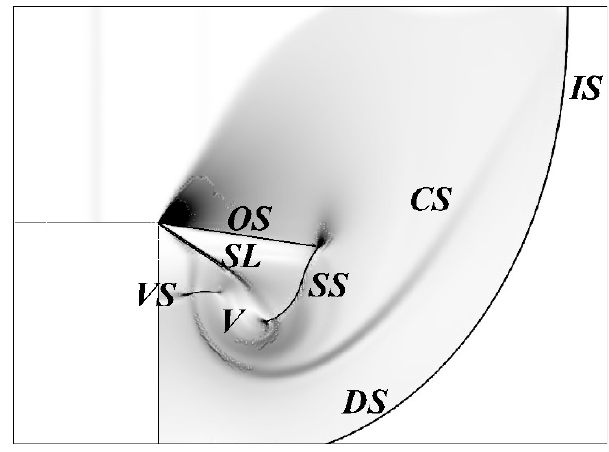
Fig. 3. Schlieren showing flow features of shock wave diffraction over a backward-facing